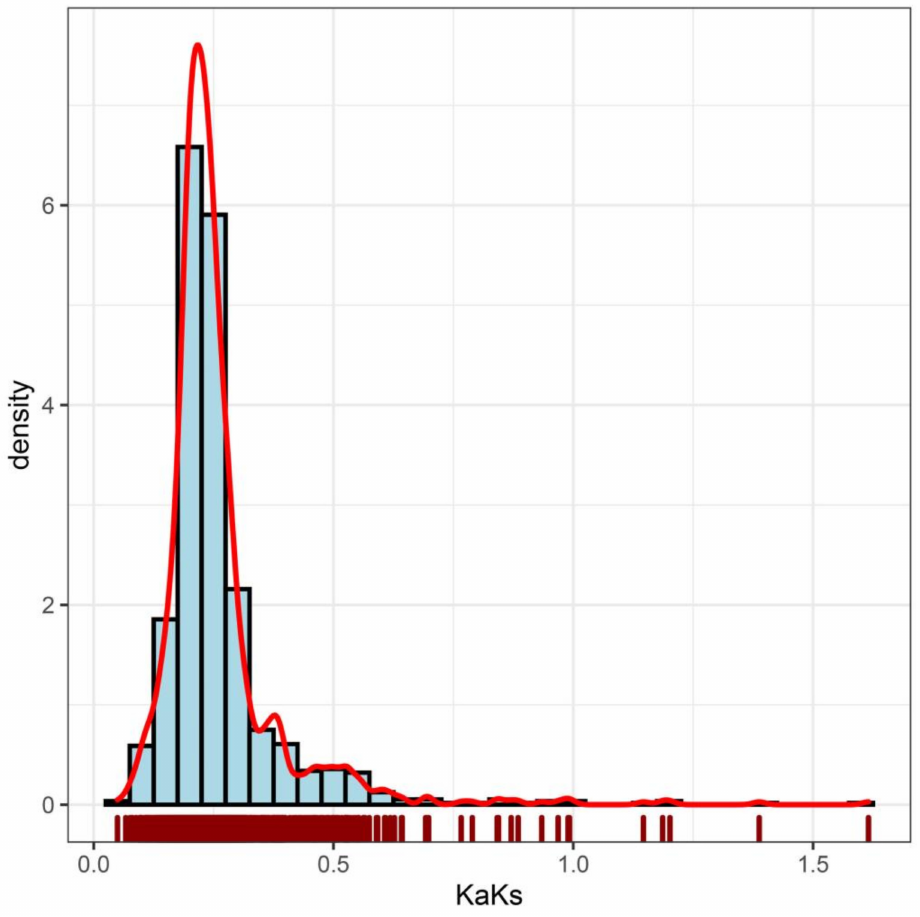
Figure 5. Ka / Ks density distribution in